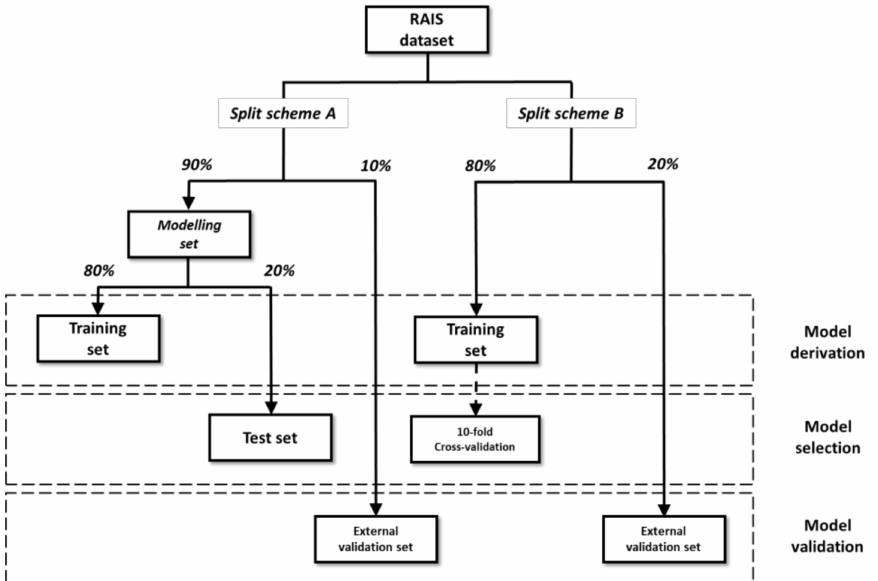
Figure 2. Graphic representation of the two schemes applied for dataset split. For each dataset, the function in model development (i.e., derivation, selection and validation) is